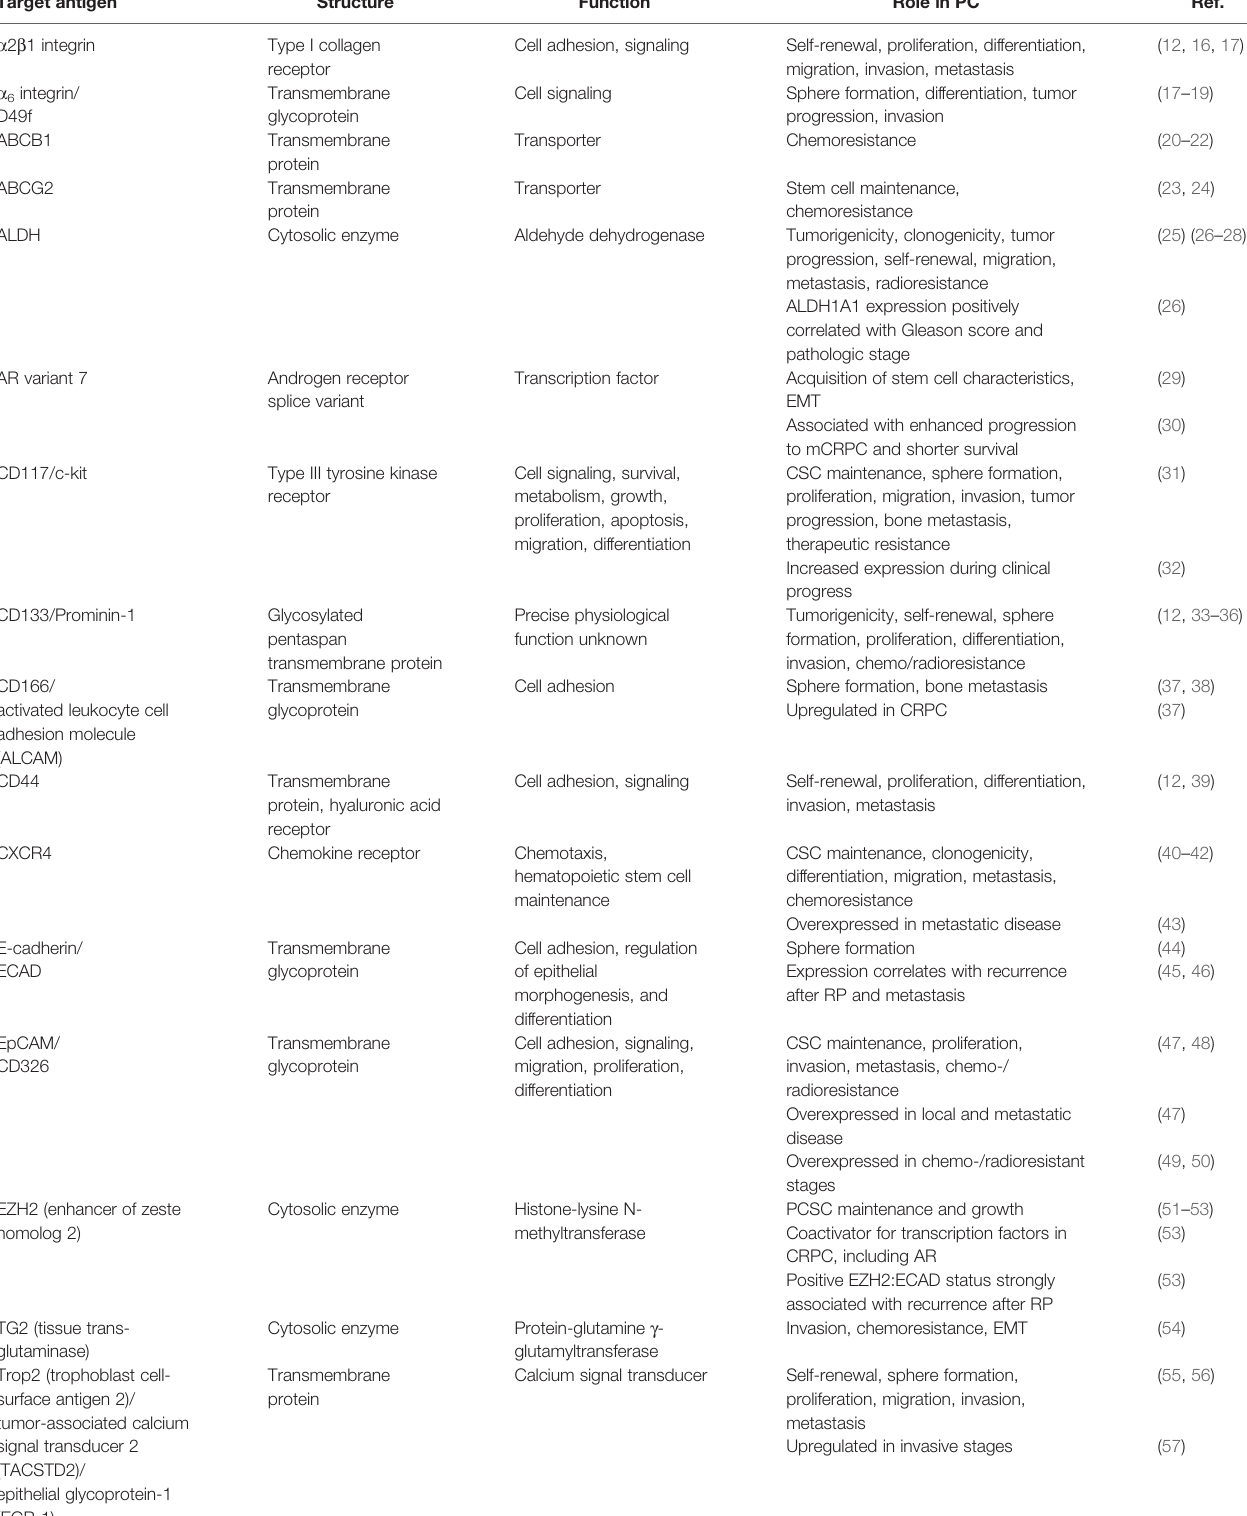
TABLE 1 | Antigens associated with